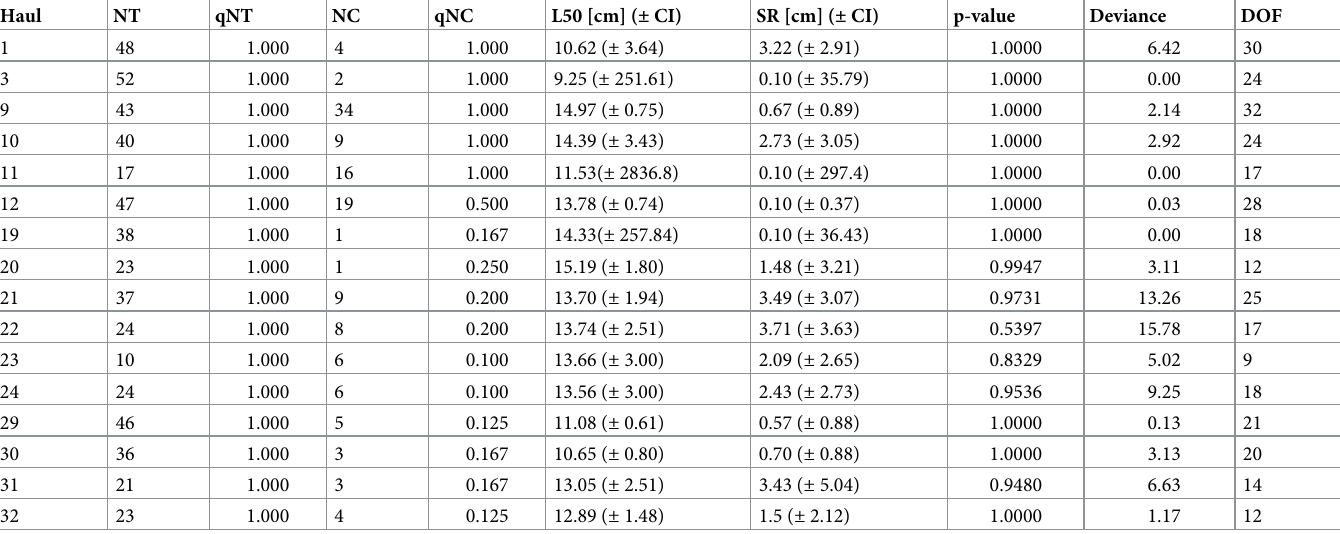
Table 4. Estimated selection parameters and fit statistics for European hake (16 hauls).